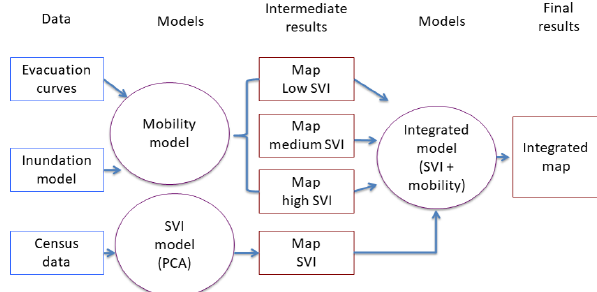
Figure 1. ReTSVI